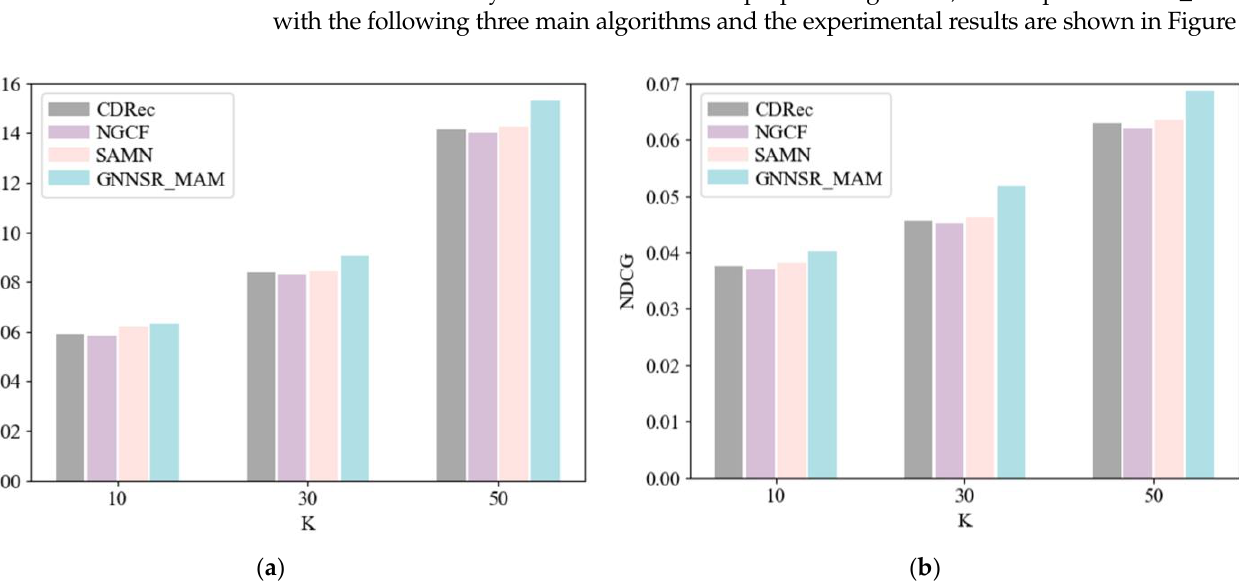
Figure 7. Comparison of the algorithms on the Epinions dataset. ( a ) Recall@K; ( b ) NDCG@K.